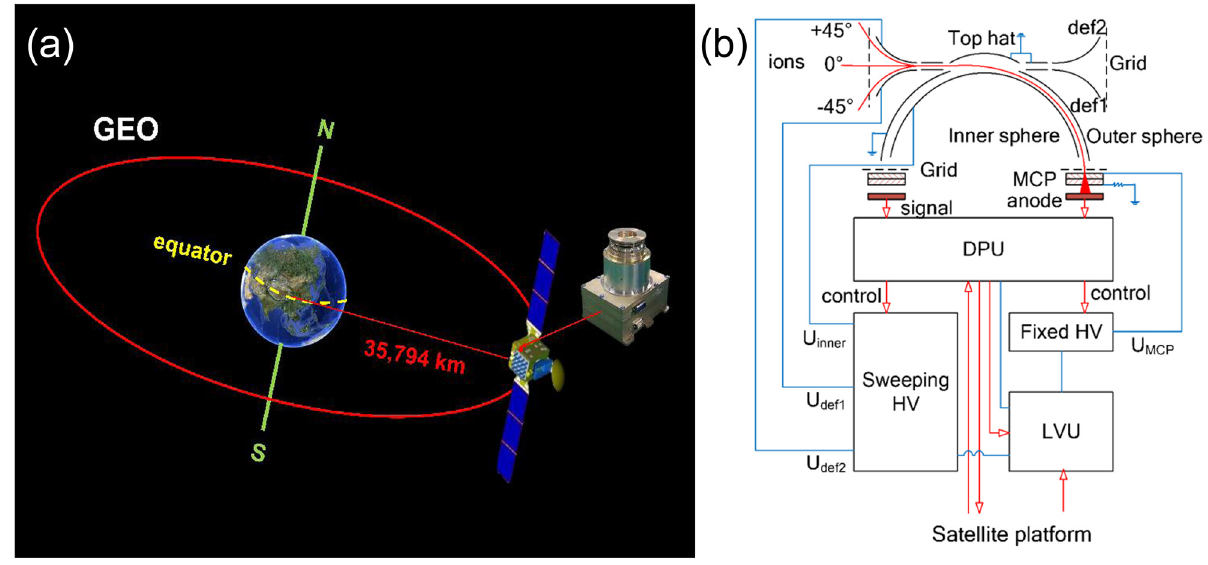
Figure 1: ( a ) Schematic diagram of the satellite fl ying along the GEO orbit around the Earth. The inset photograph is a fl ight model of the LEIS payload. ( b ) Structural and functional schematic diagram of the LEIS